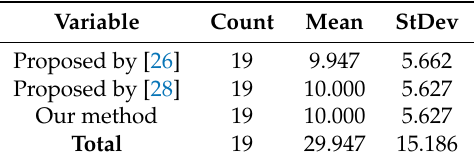
Table 10. Analysis of statistical parameters.